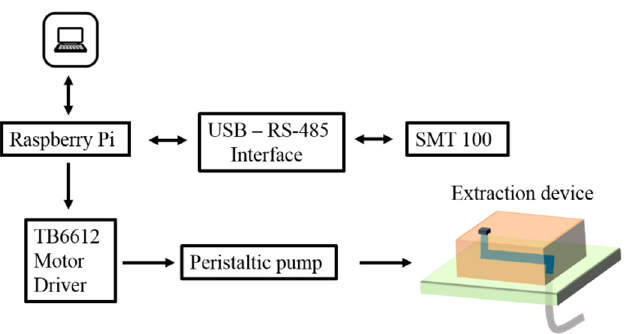
Figure 4. Hardware setup for testing the soil-solution extraction system. A miniature peristaltic pump and a reference soil-moisture sensor SMT100 were controlled by a Raspberry Pi 4